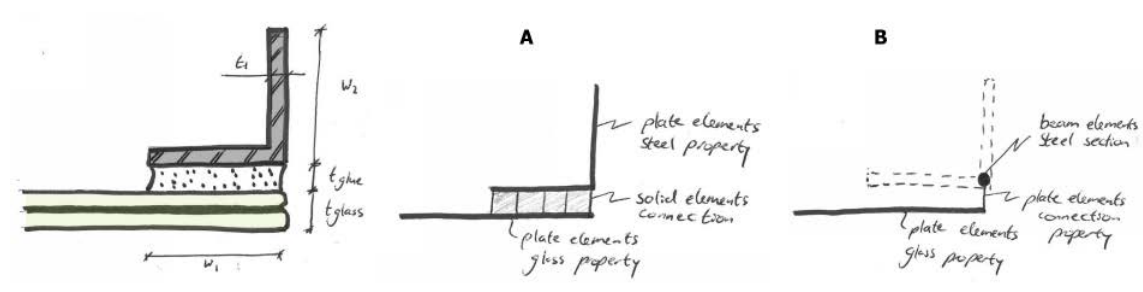
Fig.8 Sketch of frame and two types of modelling